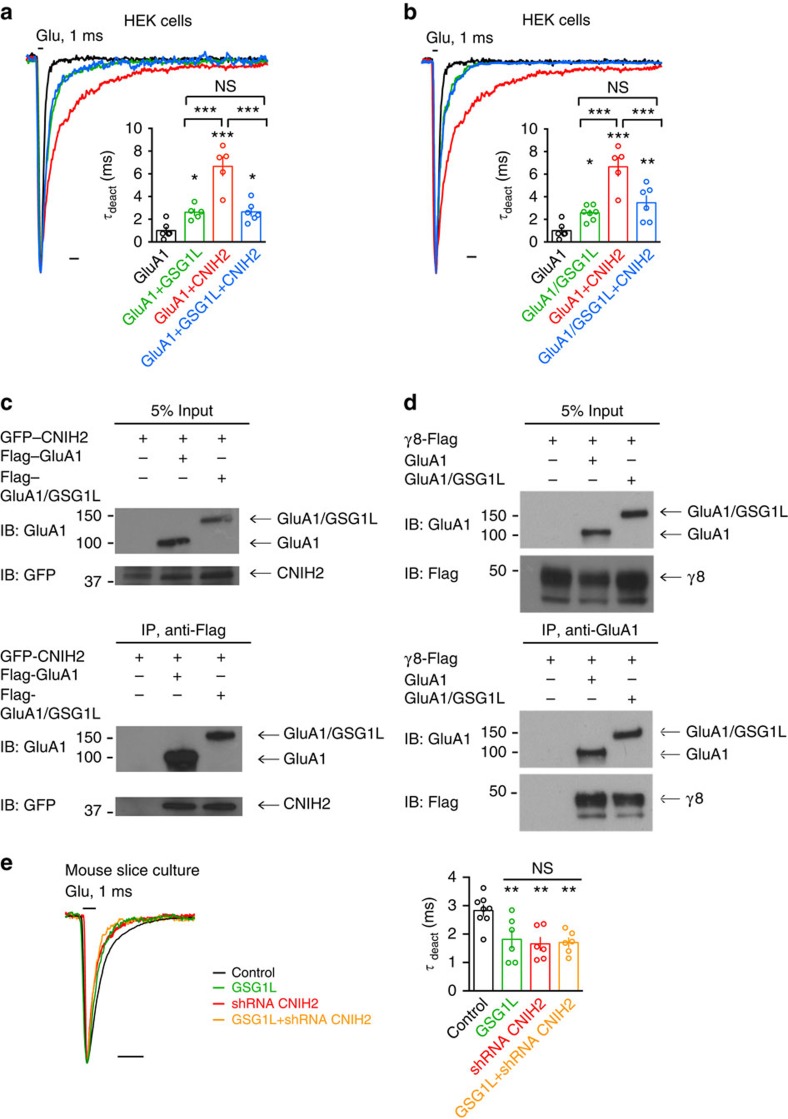
GSG1L inhibits CNIH2 effect on AMPAR deactivation kinetics.(a,b) Bar graph shows weighted time constants of deactivation
of GluA1 homomers (a, GluA1, n=6; GluA1+GSG1L,
n=5; GluA1+CNIH2, n=5;
GluA1+CNIH2+GSG1L, n=6; P<0.01) or
GluA1/GSG1L homomers (b, GluA1, n=6; GluA1/GSG1L,
n=7; GluA1+CNIH2, n=5;
GluA1/GSG1L+CNIH2, n=6; P<0.01) in HEK cells;
One-way ANOVA test; P value between individual groups was derived
from multiple comparison of ANOVA test as shown in the figure:
P<0.05, P<0.01, P<0.001). Peak-normalized
sample traces are shown above the bar graph. Scale bar, 2 ms.
(c,d) Co-IP of GluA1 or GluA1/GSG1L fusion protein with
CNIH2 (c) or γ8 (d) in HEK cells showed that both GluA1
and GluA1/GSG1L fusion protein were co-immunoprecipitated with CNIH2
(c) or γ8 (d). About 5% of the lysate used
for IP (input) was also probed with indicated antibodies to confirm protein
expression (top). (e) CNIH2 knockdown occluded the effect of GSG1L
overexpression on AMPAR deactivation kinetics in CA1 pyramidal neurons
(control, n=8; GSG1L, n=6; shRNA CNIH2,
n=6; GSG1L+shRNA CNIH2, n=6;
P<0.01 for One-way ANOVA test; P value between individual
groups was derived from multiple comparison of ANOVA test as shown in
figure, P<0.01). Peak-normalized sample traces are shown in the
left panel. Please note that AMPAR deactivation kinetics were slightly
faster in older cultures shown here than in younger cultures shown in Fig. 6a, although the difference was not significant
(two-tailed t-test, P=0.3 between control τ
numbers in Fig. 6a and 7e, P=0.22
between GSG1L τ numbers in Fig. 6a and 7e).
We performed these experiments in Fig. 7e in older
cultures because we had to wait for enough time for shRNA knockdown of CNIH2
(over a week), and thus GSG1L was also overexpressed for a longer time in
this experiment. Scale bar, 2 ms. Statistical significance is
presented as *P<0.05, **P<0.01 or
***P<0.001. NS, not significant.